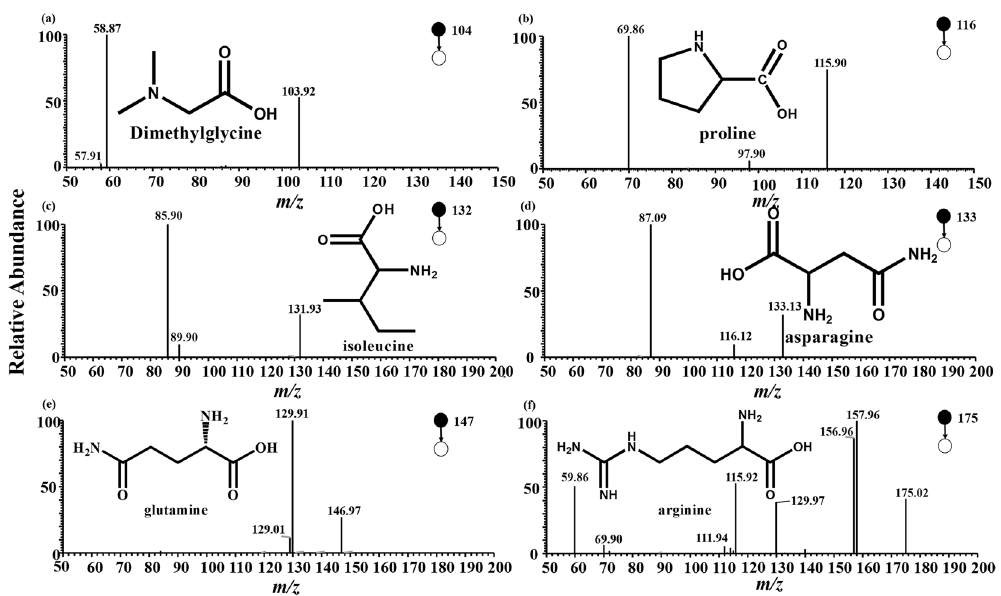
Figure 3. Product ion mass spectra by collision-induced dissociation: ( a ) DMG + H + (precursor ion m/z 104.13); ( b ) proline + H + (precursor ion m/z 116.10); ( c ) isoleucine + H + (precursor ion m/z 132.13); ( d ) asparagine + H + (precursor ion m/z 133.11); ( e ) glutamine + H + (precursor ion m/z 147.08), and ( f ) arginine + H + (precursor ion m/z